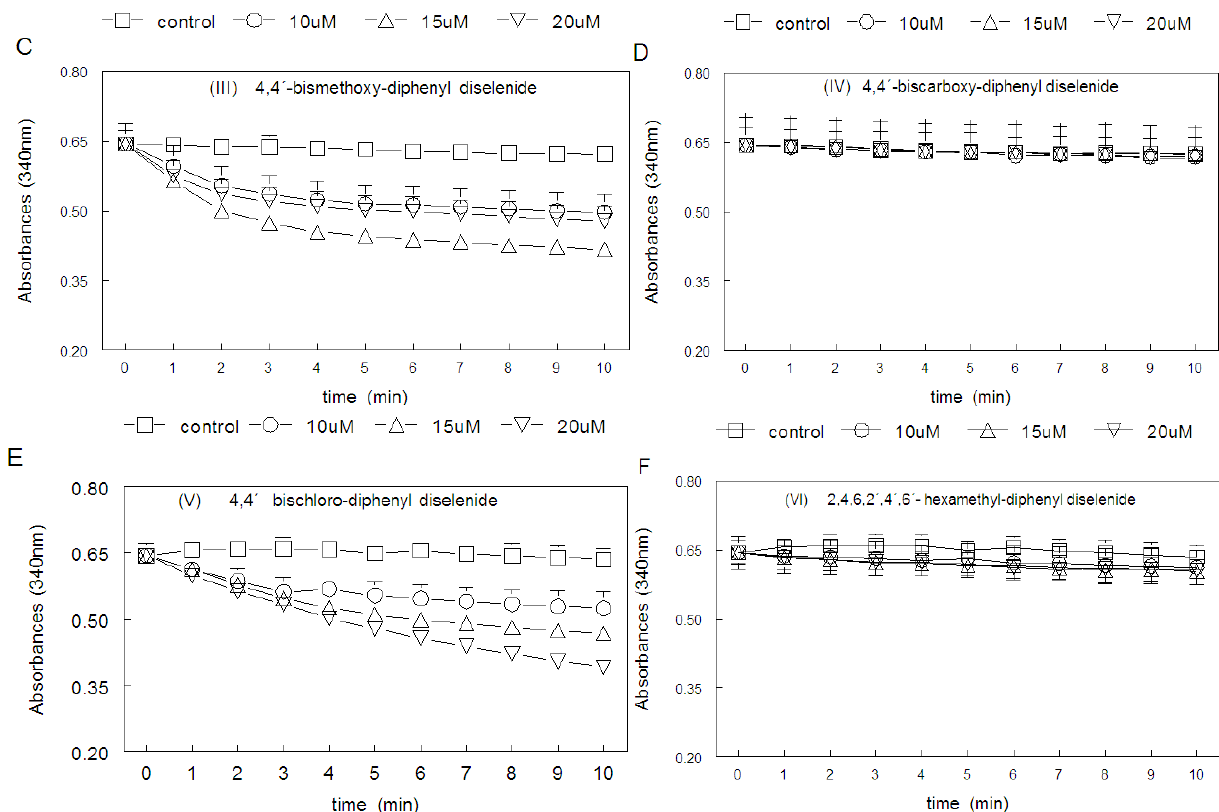
Figure 3. Reduction of ebselen (0, 5, 7.5, 10, 15 or 20 µM) by NADPH catalyzed